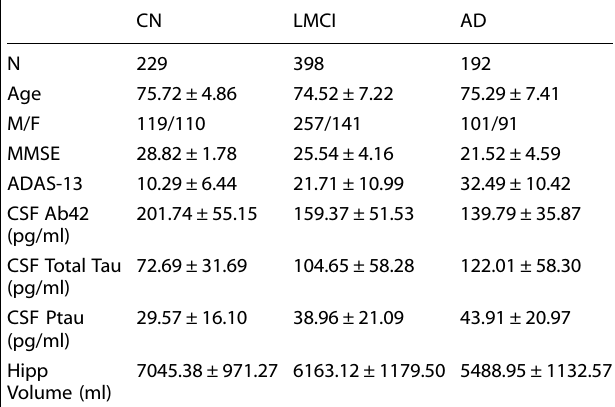
Table 4. The characteristics of the ADNI-1 dataset in data-driven modeling.